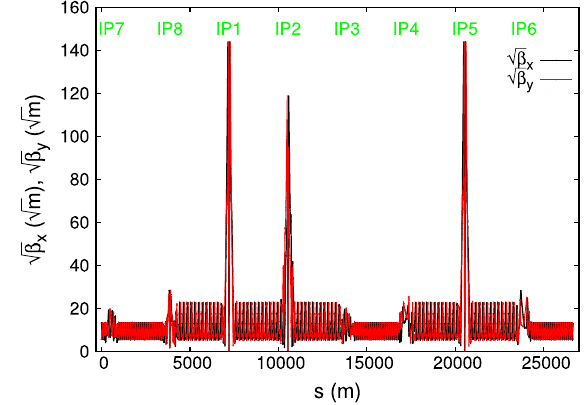
FIG. 5. LHeC ATS collision optics for beam 2 with β (cid:1) ¼ 10 cm at IP2 and β (cid:1) ¼ 15 cm at IP1 and